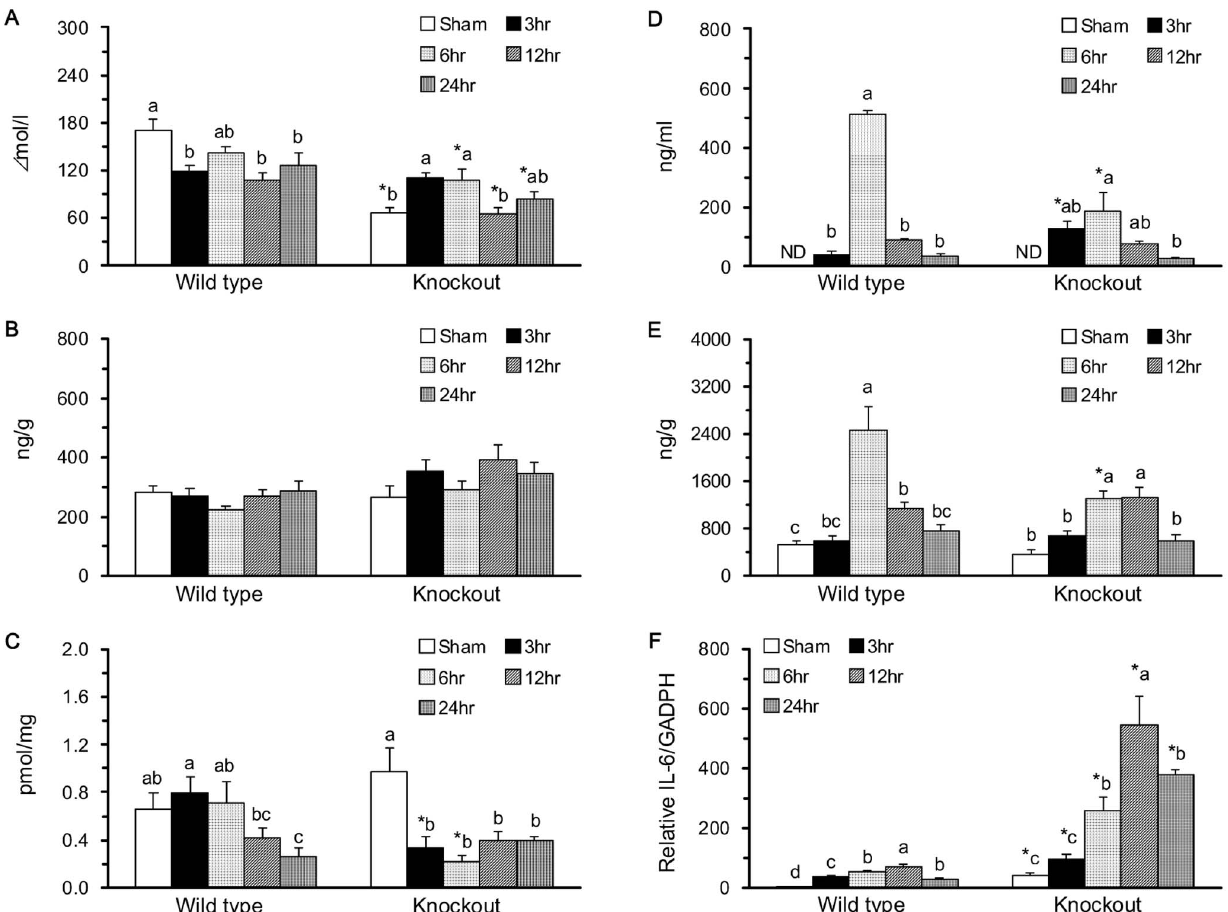
Figure 2. Nitrite/nitrate (NOx), cyclic GMP, and IL-6 protein and mRNA expression in the plasma and jejunum. Plasma NOx (A), jejunal NOx (B), jejunal cyclic GMP (C), plasma IL-6 (D), jejunal IL-6 protein (E), and the relative IL-6 mRNA expression in the jejunum after adjustment with GAPDH mRNA levels (F). Means 6 SEM, n=10 for the WT groups and n=9 for the KO groups. *P , .05, KO vs. WT mice with sham operation or with intestinal IR at the same time point (Student’s t-test,). Values with different superscripts indicate significant differences within all of the time points in WT and KO mice, individually (one-way ANOVA with LSD, P , .05).